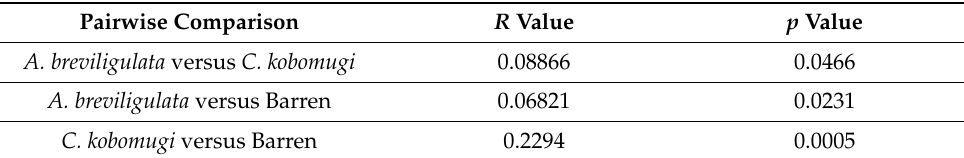
Table 1. Results of pairwise ANOSIM of community composition. R values were derived from Bray–Curtis similarity matrices using 9999 permutations.